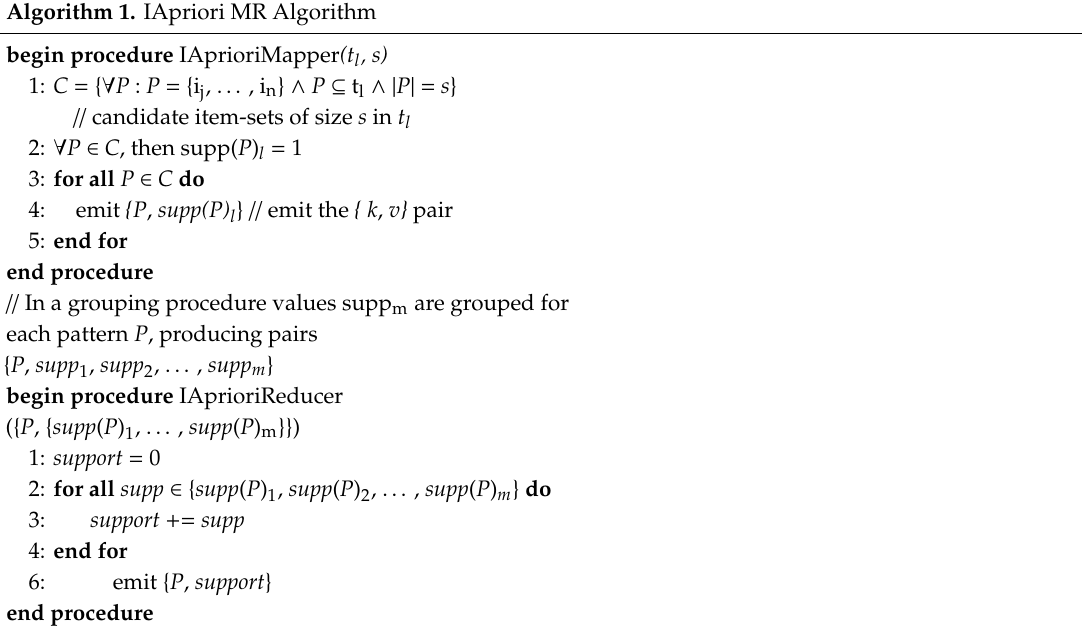
Algorithm 1. IApriori MR